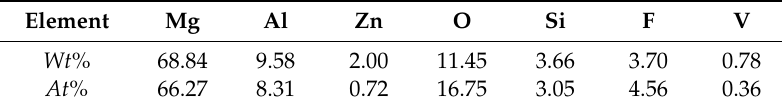
Figure 6. Map scanning analysis of cross-section of MAO coating processed with 0.8 g/L V 2 O 5 under 480 V:( a ) SE1; ( b )Mg; ( c )Al; ( d ) Zn; ( e ) O; ( f ) Si; ( g ) F; ( h ) V. Table 2. EDS results of MAO coating processed with 0.8 g/L V 2 O 5 under 480 V.